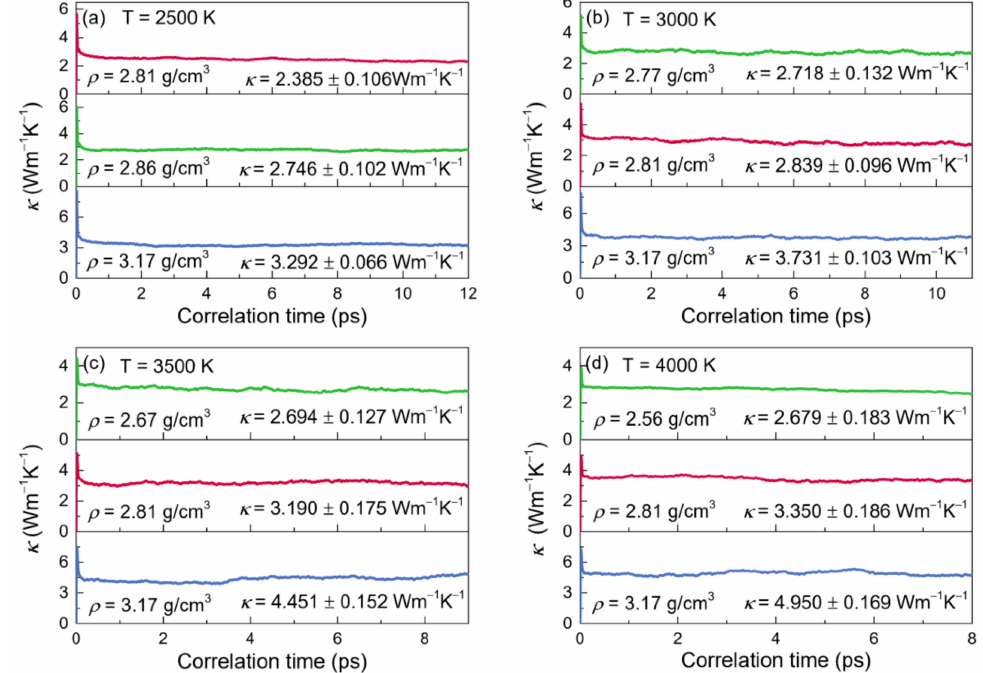
Figure 8. Thermal conductivities ( κ ) for the configurations of liquid alumina with three different densities at ( a ) 2500 K, ( b ) 3000 K, ( c ) 3500 K and ( d ) 4000 K,